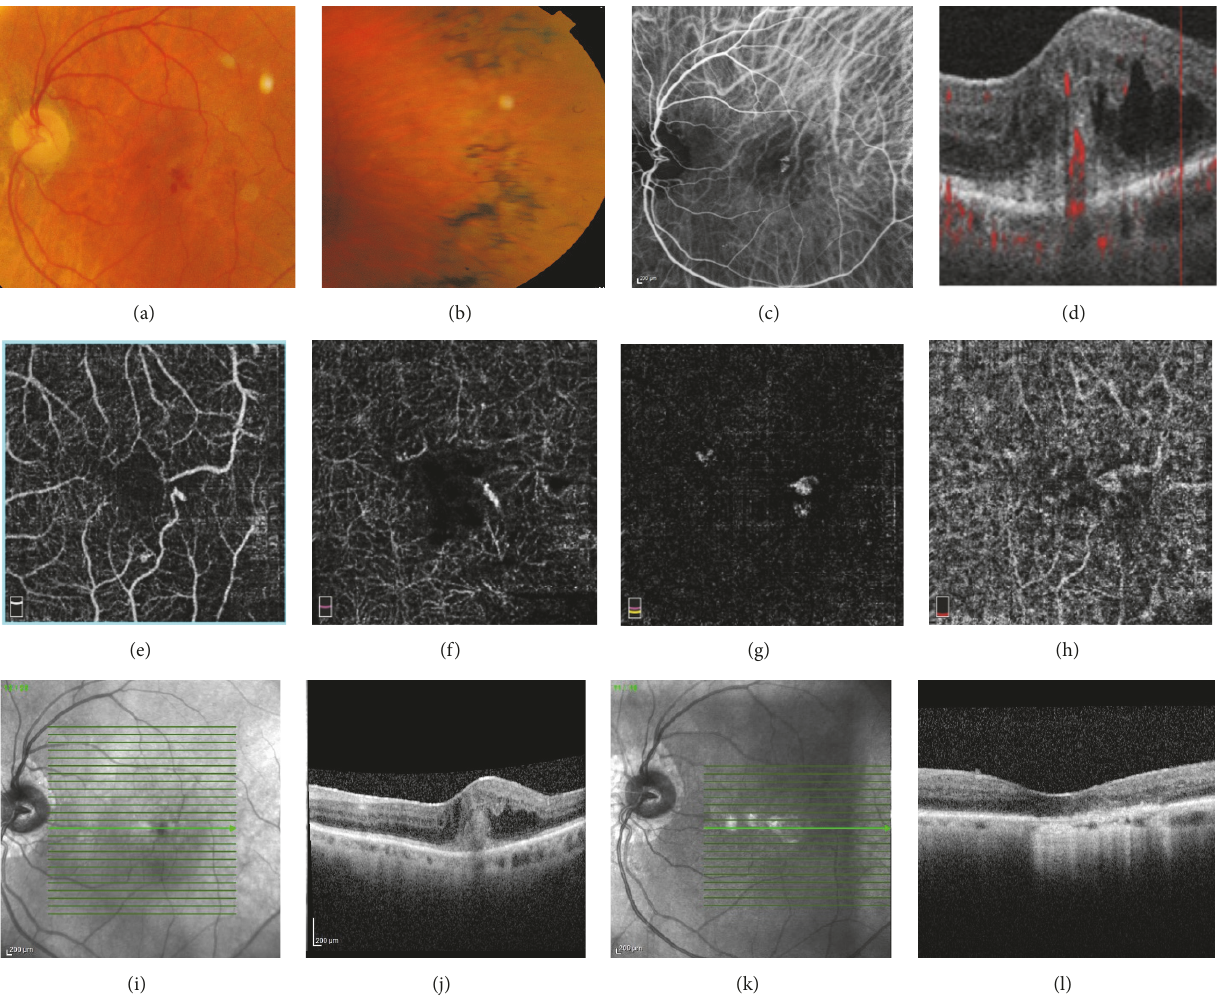
Figure 1: (a)-(b) Colour fundus photography showed arteriolar attenuation, peripapillary atrophy, optic disc pallor, macular hemorrhage and typical retinal pigment deposits (bone spicules) involving the mid-peripheral retina (c) Indocyanine green angiography (ICGA) revealed a well-distinct “triangular shape” area of intense hypercyanescence (“hot spot”) corresponding to the neovascularization (d) B-Scan optical coherence tomography angiography revealed high-flow intraretinal neovascularization originated in the superficial layer descending into a tuft-shaped lesion toward the sub-RPE space. (e)–(h) Optical Coherence Tomography Angiography images (6 × 6 mm) revealing the progression of the tuft-shaped lesion from the superficial layer to choroid capillary. (e) Superficial capillary plexus segmentation. (f) Deep capillary plexus segmentation. (g) Outer retinal layer segmentation. (h) Choriocapillaris segmentation. (i)–(j) Spectral Domain-Optical Coherence Tomography at baseline. (k)–(l) Spectral Domain-Optical Coherence Tomography after